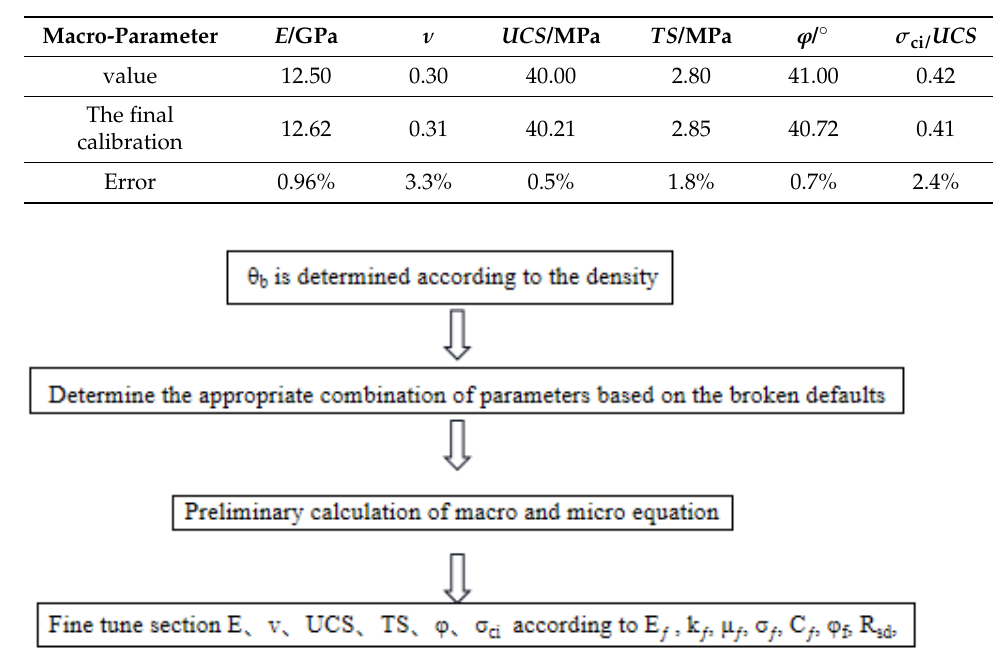
Table 9. Final soft rock calibration [29,30].